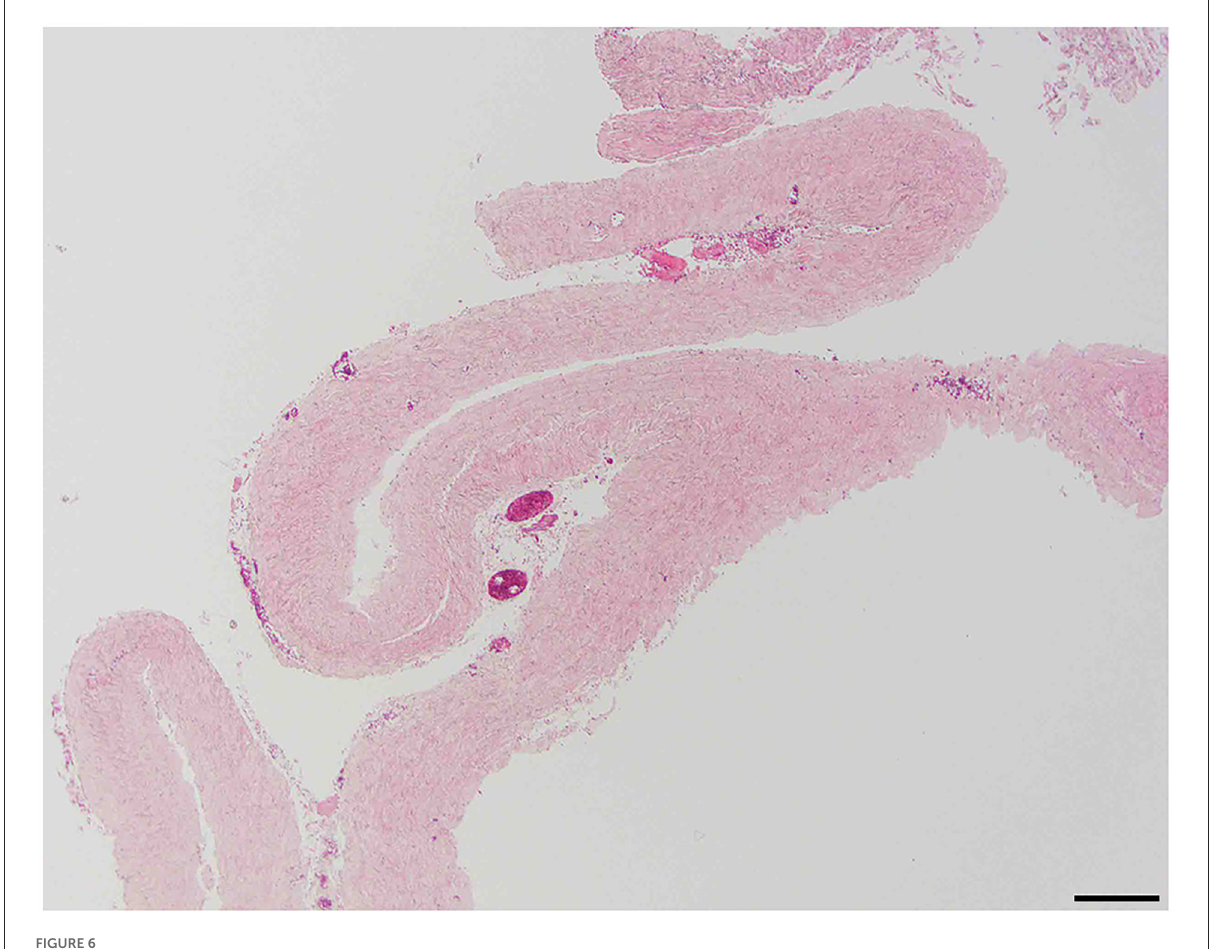
FIGURE6 Control specimen; 40 × –Scale bar = 50 microns.